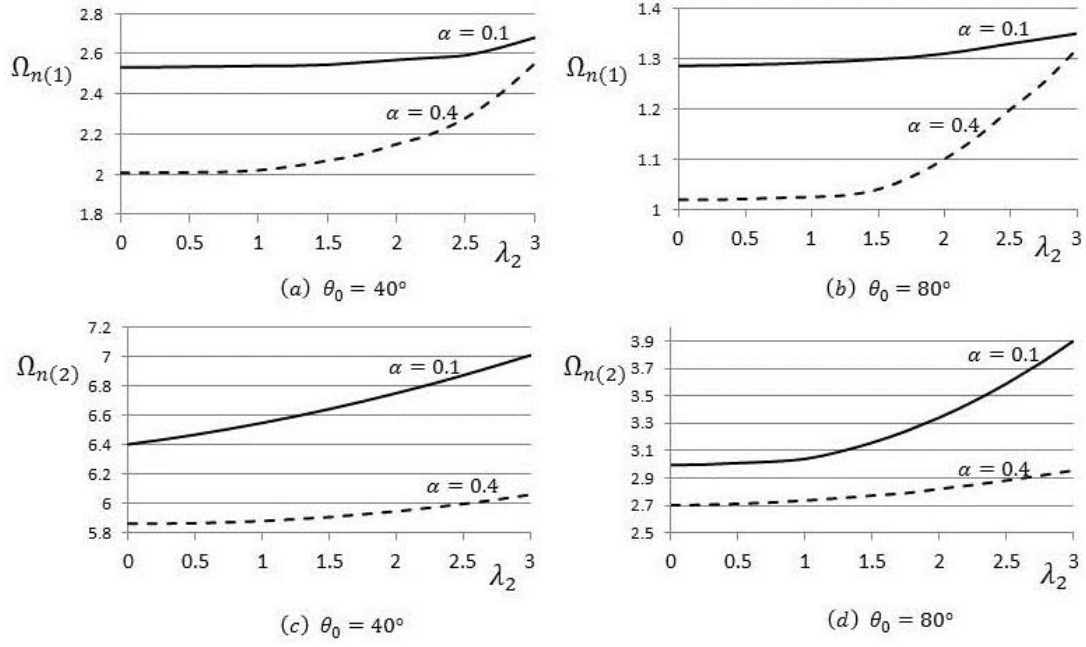
Figure 5. First and second natural frequencies’ variations with the rotation speed (𝜆 2 ) for different taper parameter (𝛼) and opening angle (𝜃 0 ) values.